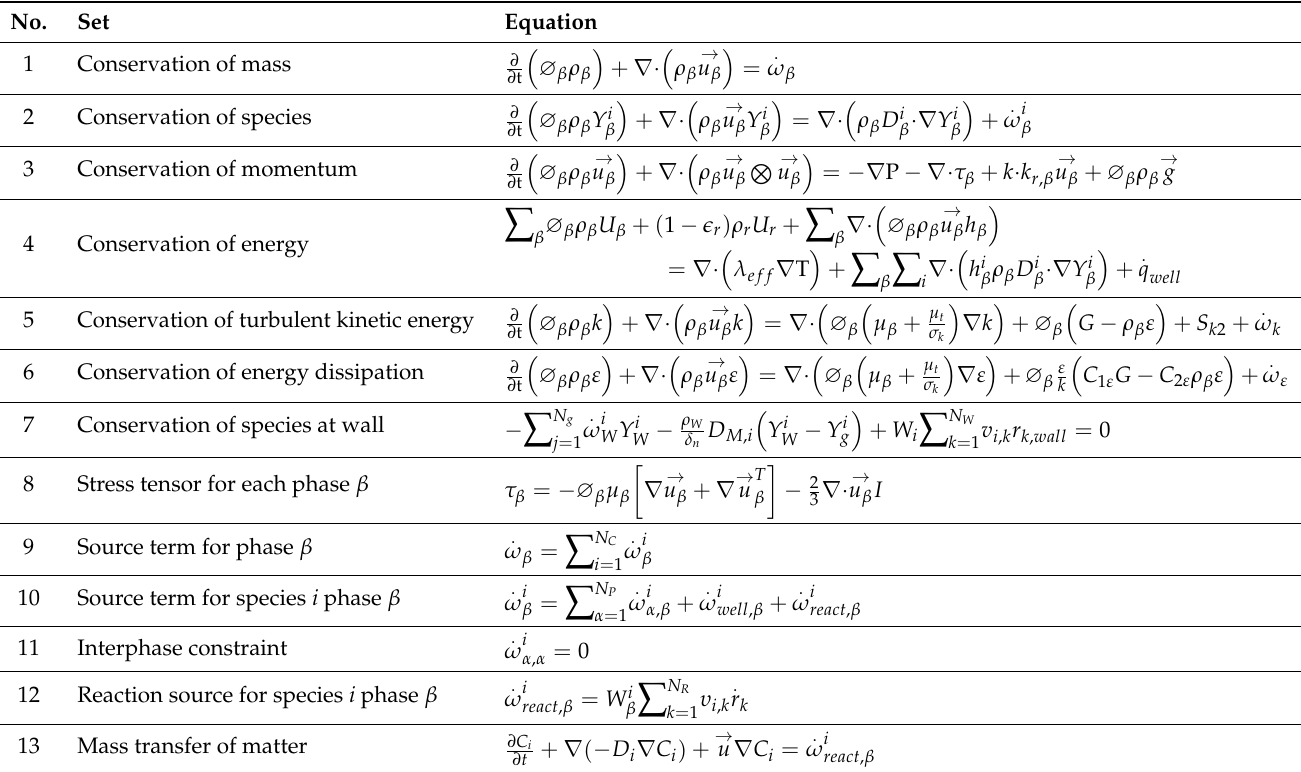
Table 1. Governing equations related to UCG [from